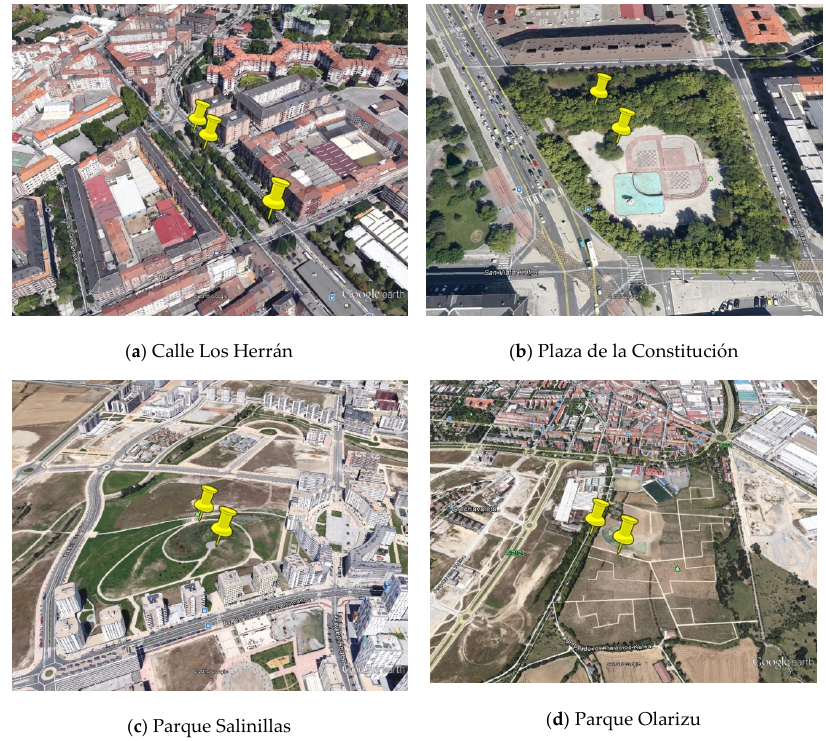
Figure 2. Pictures of the four urban places, indicating the evaluation points. Source: Google Earth.